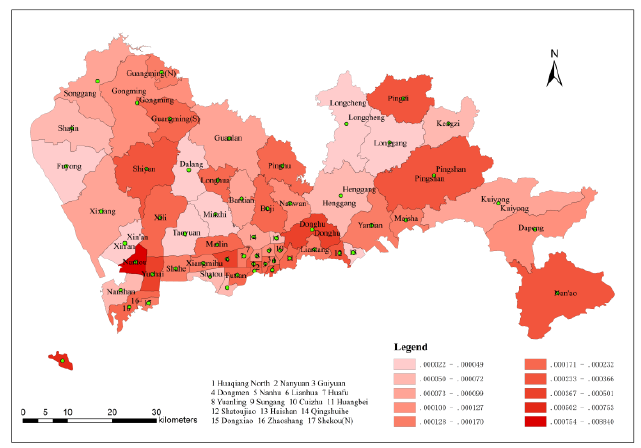
Figure 5. ( a ) The spatial distribution of hepatitis B morbidity (non-interpolated) ( b ) The spatial distribution of hepatitis B morbidity (with